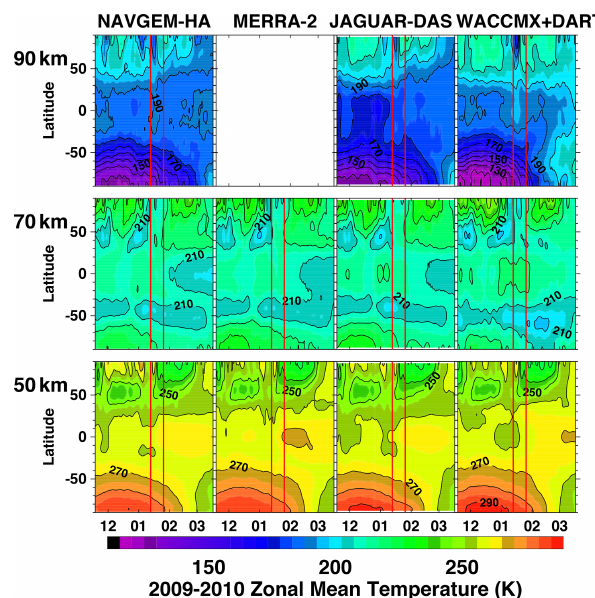
Figure 7. Latitude–time cross-sections from 1 December 2009 to 31 March 2010 of daily mean zonal mean tem- perature in NAVGEM-HA, MERRA-2, JAGUAR-DAS, and WACCMX + DART at 90km (top), 70km (middle), and 50km (bottom). Contours are drawn every 20K. Vertical red lines in each panel denote 27 January and 9 February, as described in the text. Month tick labels along the x axes are placed at the 15th of each month.